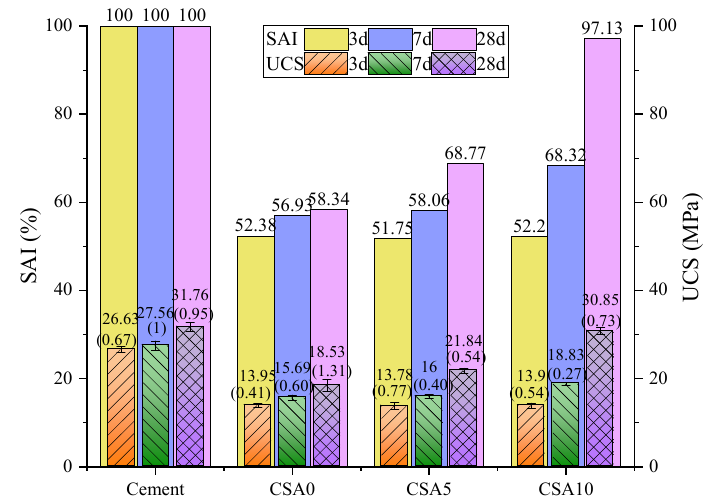
Figure 4. SAI and UCS of blended cement pastes.